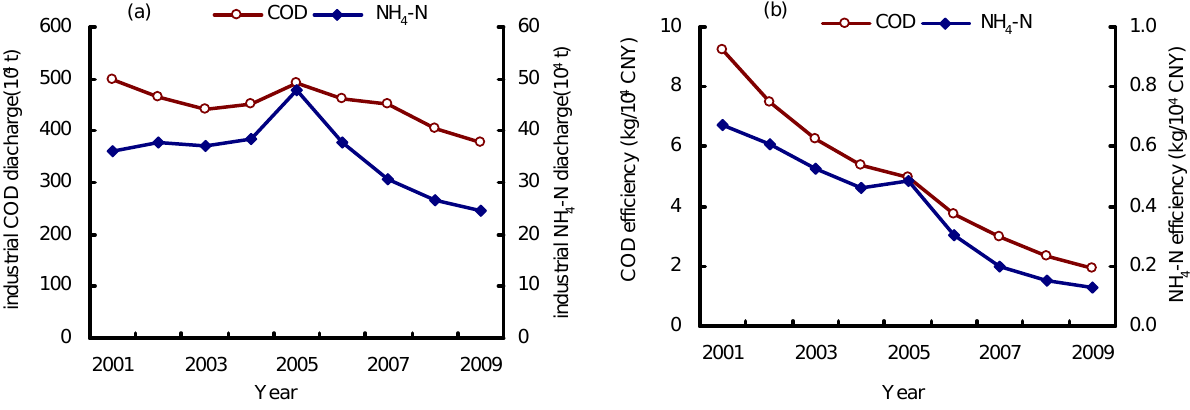
Figure 2. Changes of the wastewater discharges in industrial wastewater during 2001–2009, ( a ) pollutant discharges; ( b ) pollutant discharge efficiency (Data resources: ASREC [4]).